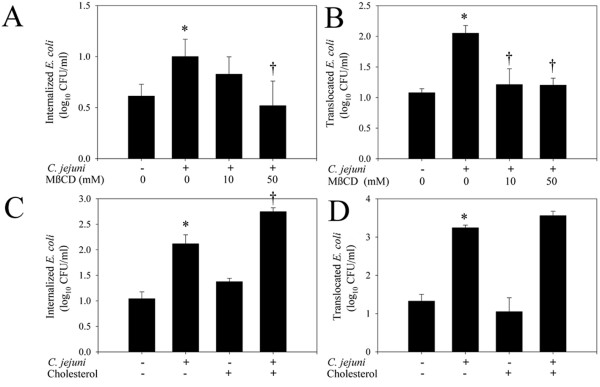
Plasma membrane cholesterol affects C. jejuni-induced E. coli internalization and translocation. Cholesterol depletion prevents C. jejuni 81–176-induced (A) internalization, and (B) translocation of E. coli HB101 in confluent T84 monolayers, 4 h post-infection. (n = 3). Increased plasma membrane cholesterol promotes C. jejuni 81–176-induced internalization (C) of E. coli, but does not affect E. coli translocation (D), 4 h post-infection. (n = 4). Data are means ± SEM, *P < 0.05 compared to untreated non-infected monolayers. †P < 0.05 compared to untreated C. jejuni-infected monolayers.